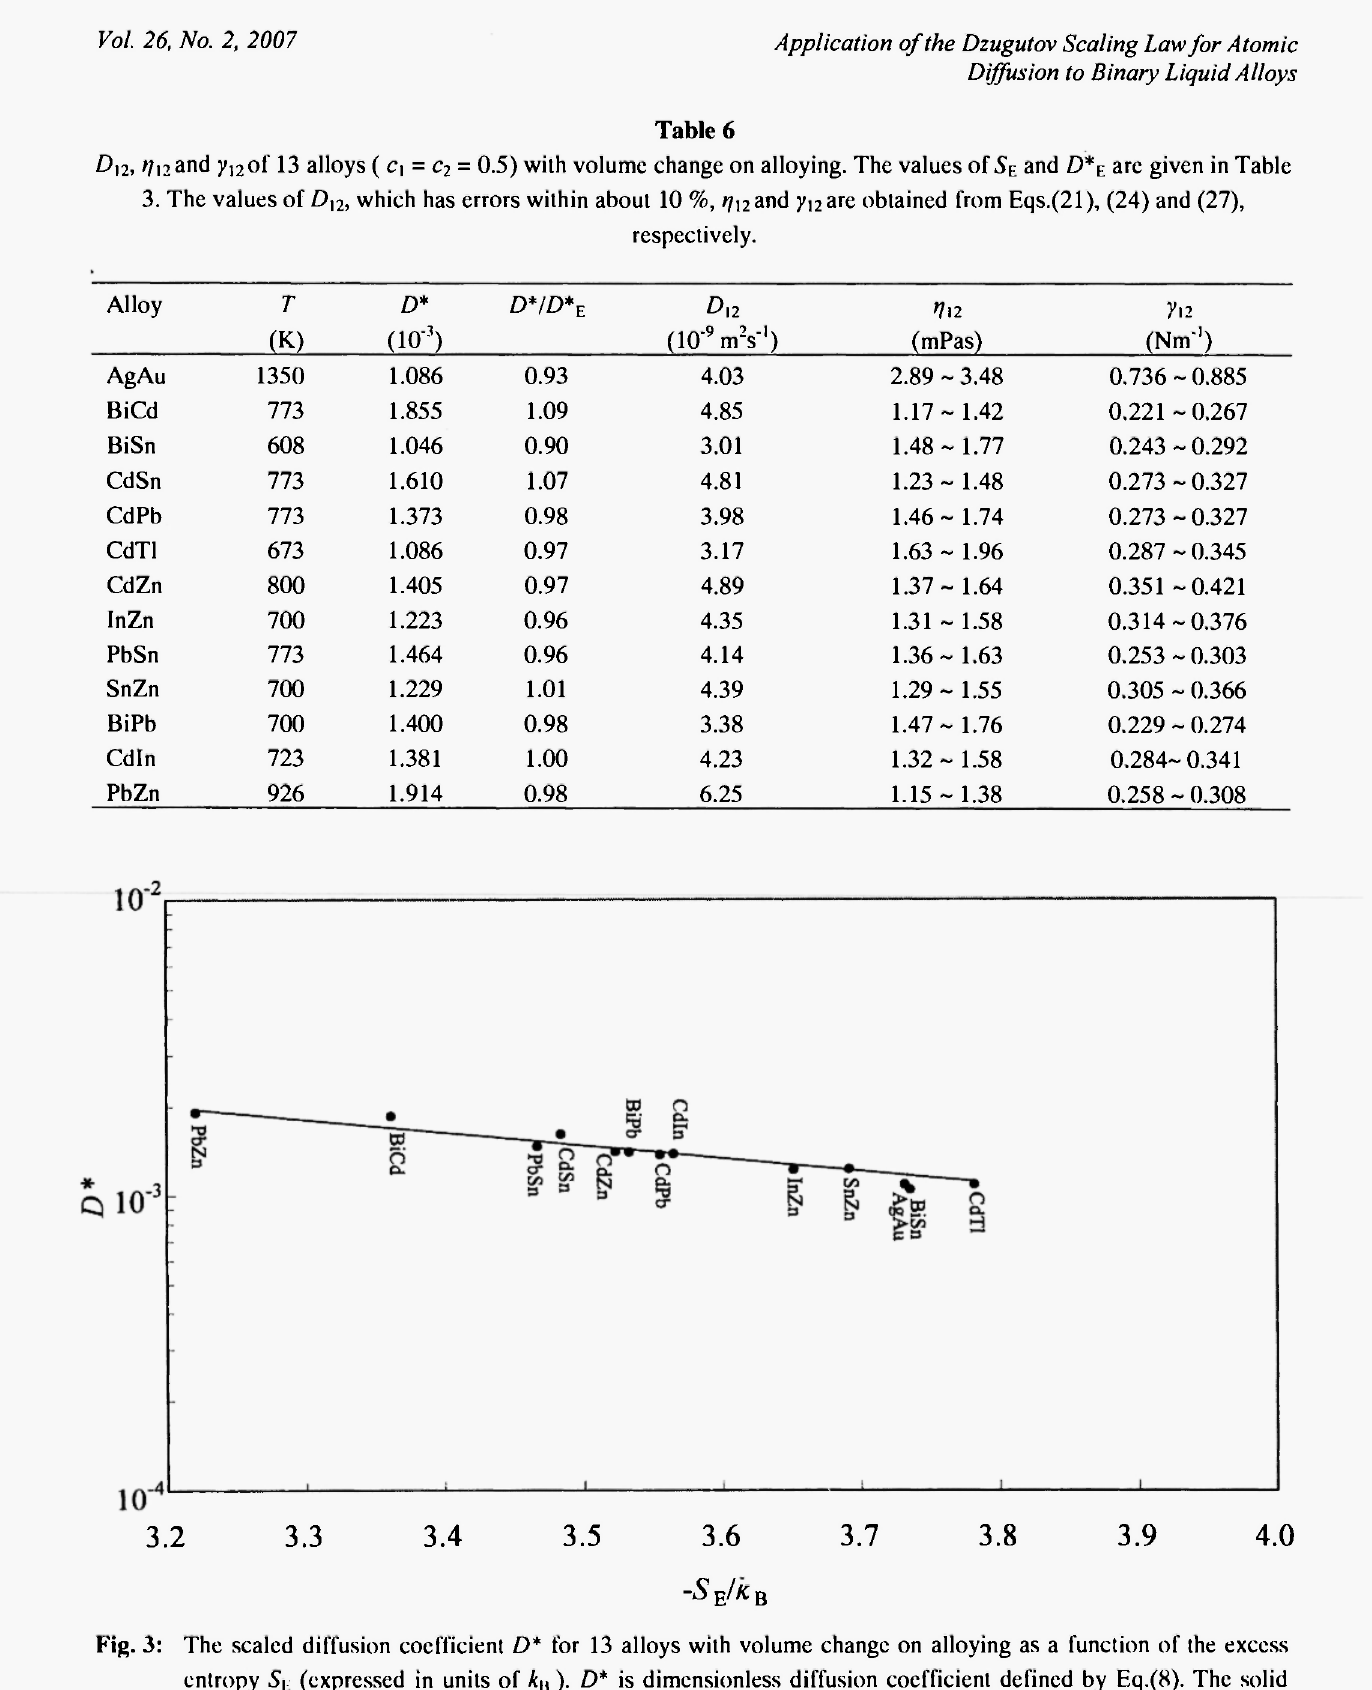
Fig. 3: The scaled diffusion coefficient D* for 13 alloys with volume change on alloying as a function of the excess entropy S|. (expressed in units of ). D* is dimensionless diffusion coefficient defined by Eq.(8). The solid line denotes D*\ obtained from